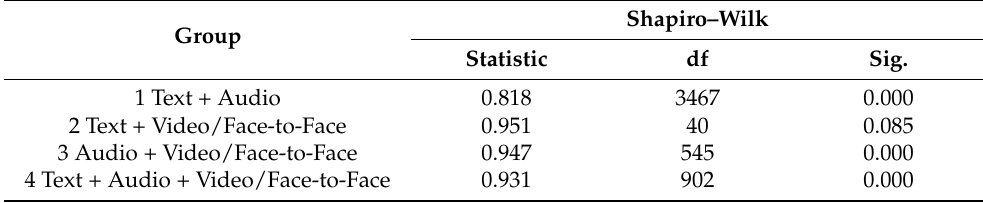
Table 3. Tests of normality—satisfaction in mixed media.